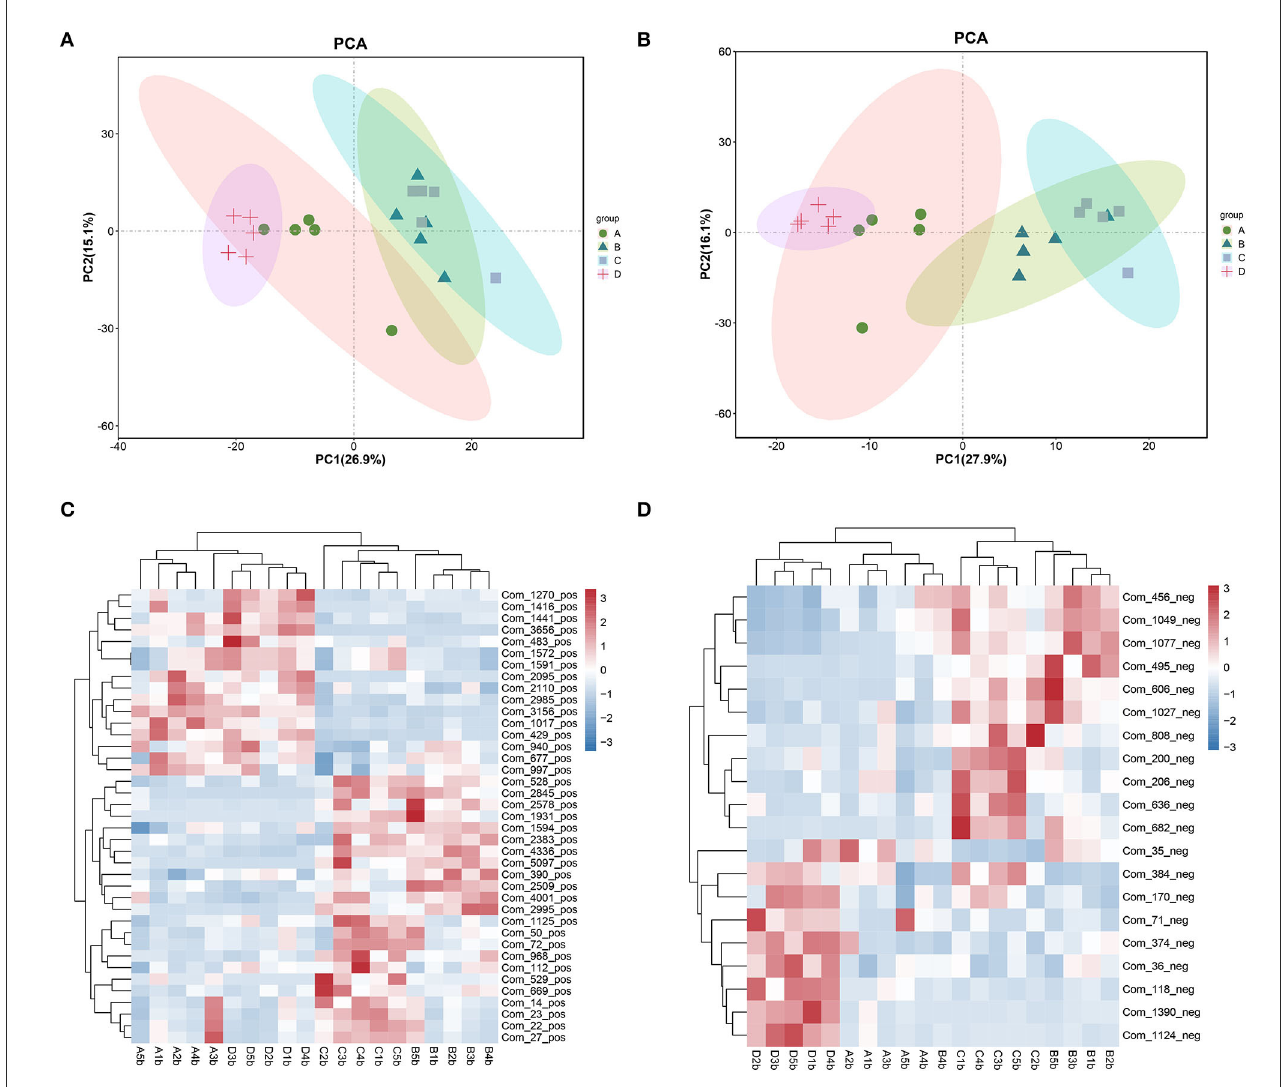
FIGURE5 PCA showing the metabolomic profiles of the fecal contents and a heatmaps showing the significantly different metabolites among the four groups. (A, C) positive ion mode. (B, D) negative ion